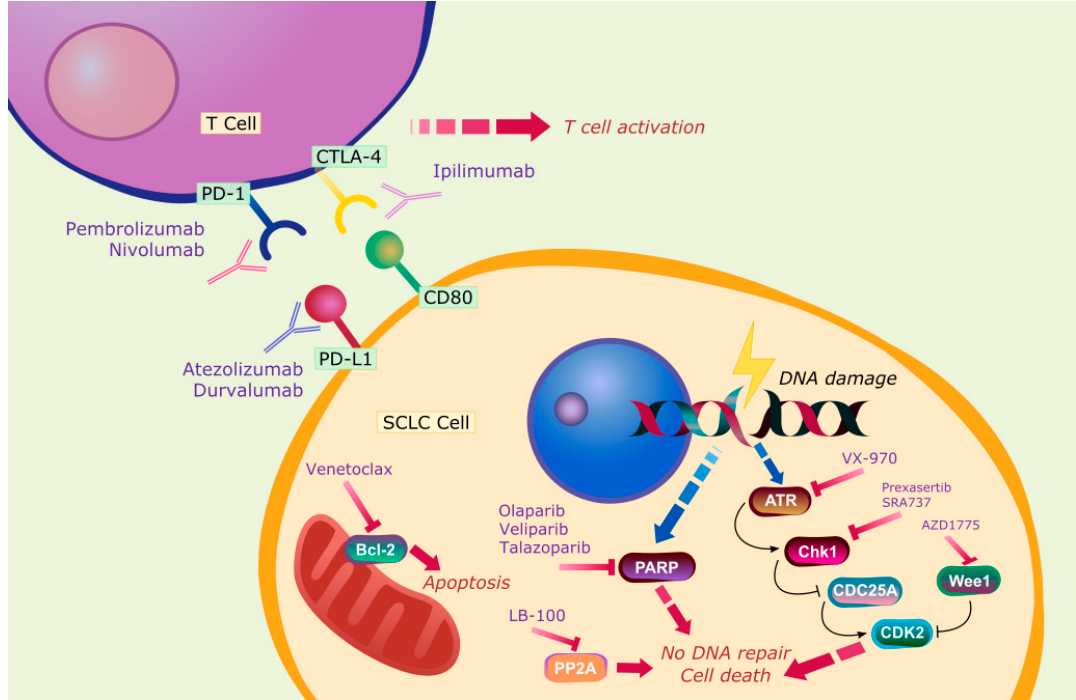
Figure 1. Current investigational immunotherapies and targeted therapies for small cell lung cancer SCLC.